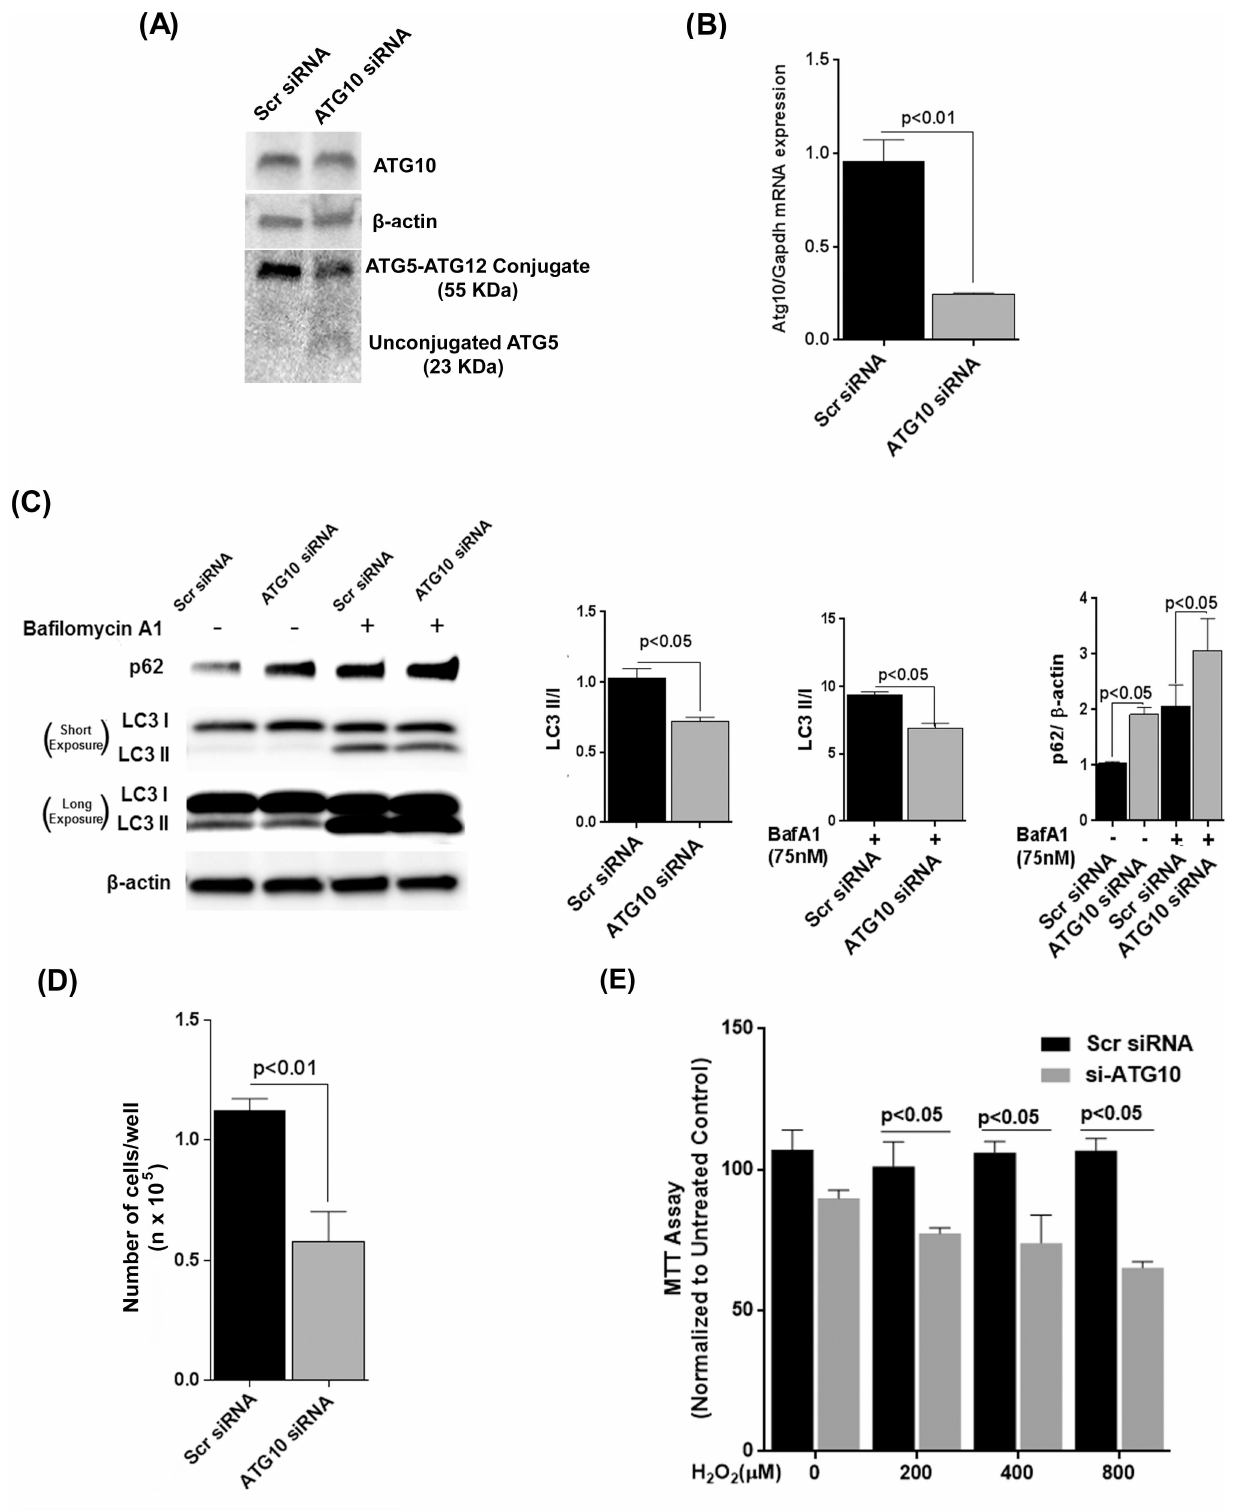
Fig 9. Knockdown of ATG10 makesARPE-19 cells more sensitive to H 2 O 2 . (A) ARPE-19 cells were transfected with pooledATG10 specific siRNAs or scrambledsiRNA (30nM) for 24h. ATG10 and ATG5 levels were assessed in protein lysates by Western Blot. (B)